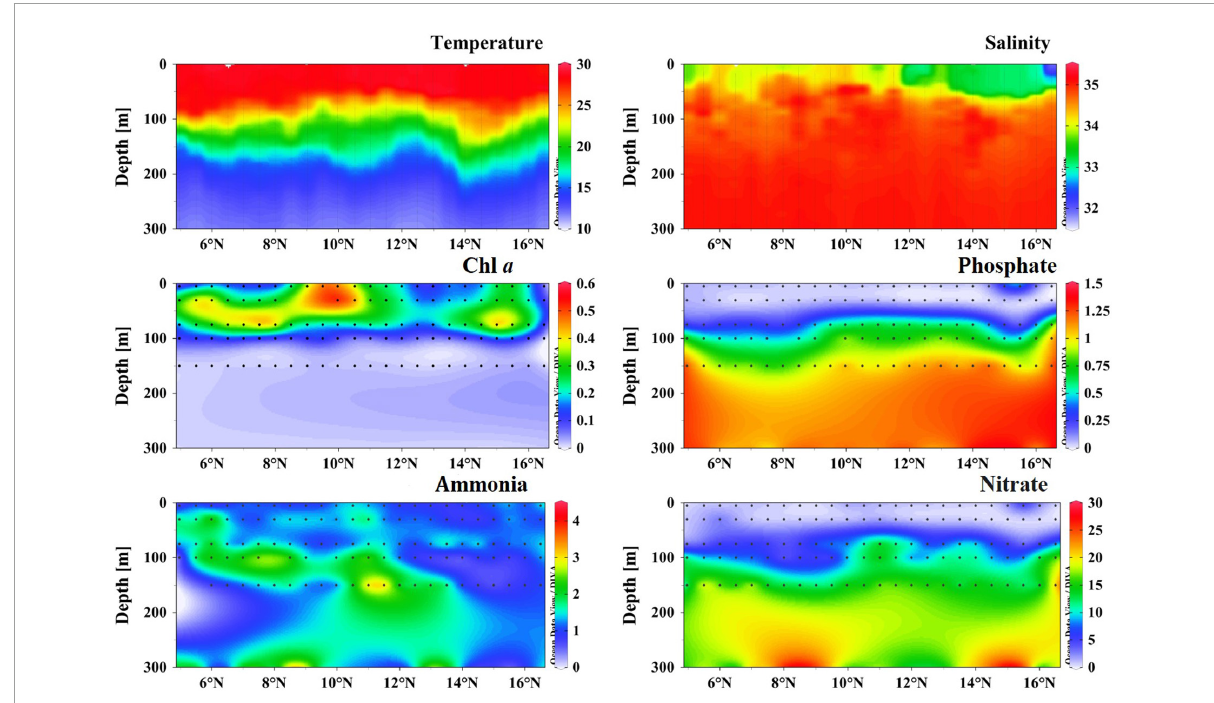
FIGURE2 Vertical profiles of temperature ( ◦ C), salinity, Chl a ( µ g/L), phosphate ( µ M), ammonia ( µ M), and nitrate ( µ M) concentration in the sampling transect.